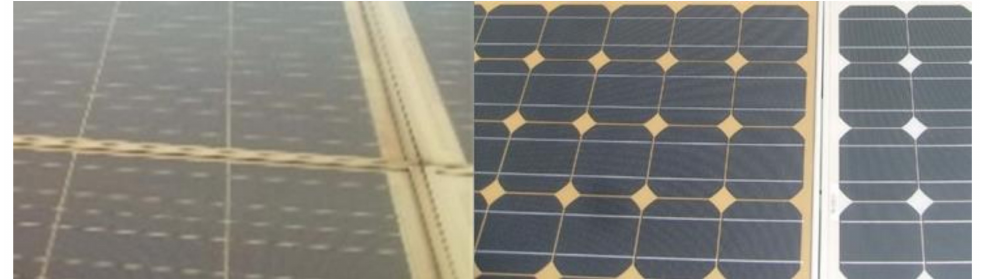
Figure 7. Discolored solar